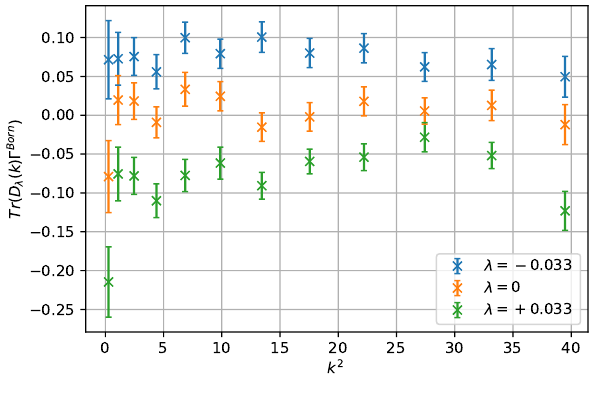
√ 4, for 3 values of λ .